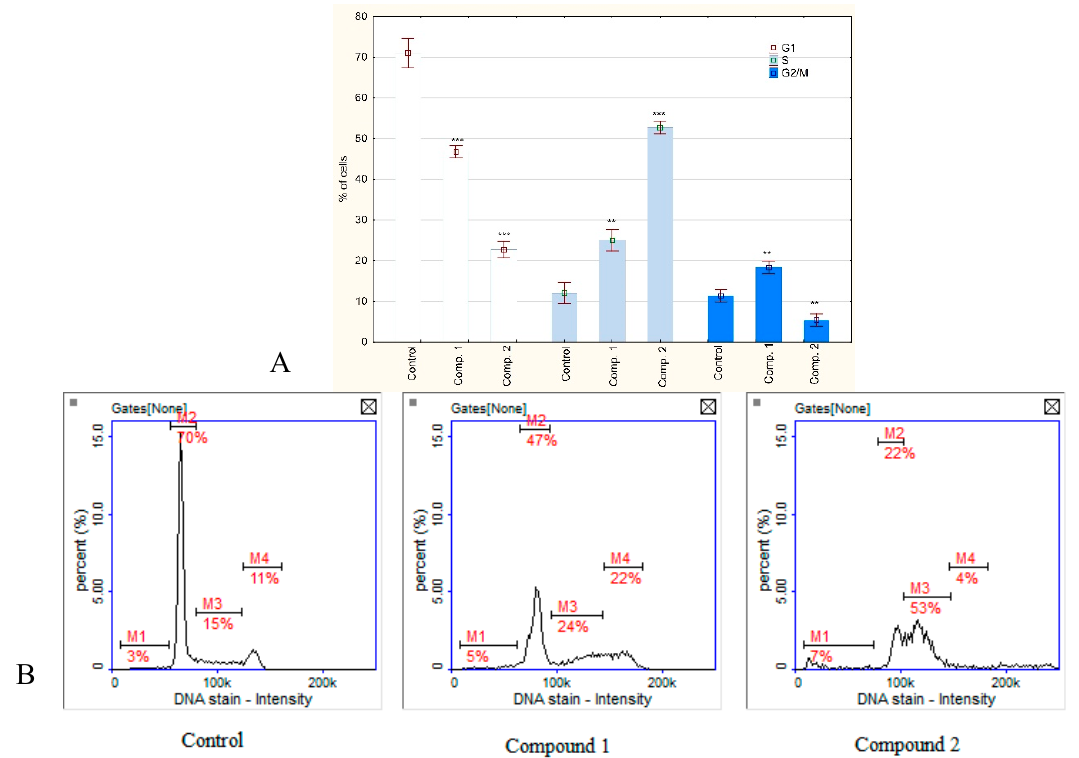
Figure 7. (A ) Cell cycle analysis through DAPI (4 ′ ,6-Diamidine-2 ′ -phenylindole dihydrochloride) staining and image cytometry by NucleoCounter NC-3000. The results were calculated as % of control values that were averaged to define the 100%. The MKN74 cells were treated with compounds 1 and 2 (250 µM) for 24 hours. Values were presented as mean ± SD derived from three independent experiments. ** p < 0.01, *** p < 0.001 vs. control; (ANOVA followed by Tukey’s HSD post hoc analysis). ( B ) Representative histograms (M1-4: cell cycle phases subG1, G1, S, G2 / M, respectively).